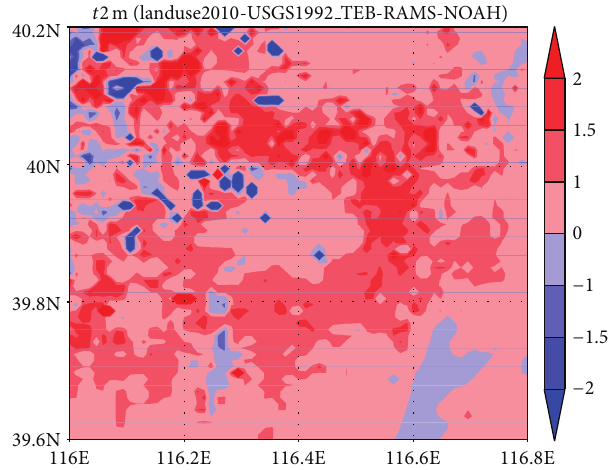
Figure 9: Spatial distribution of the 2m air temperature difference (K)